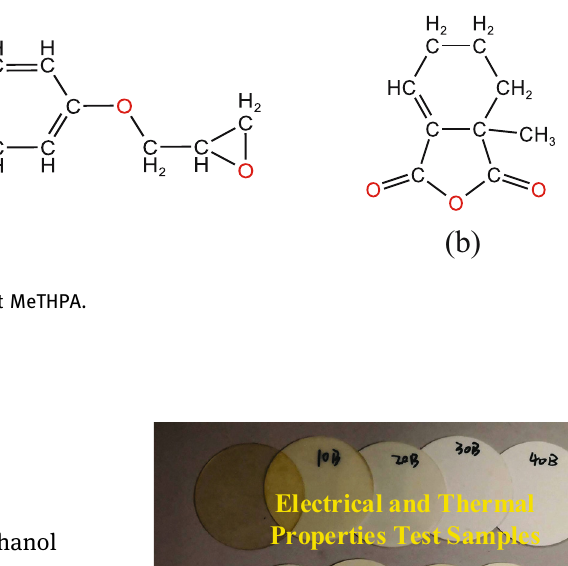
Electrical and Thermal Properties Test Samples